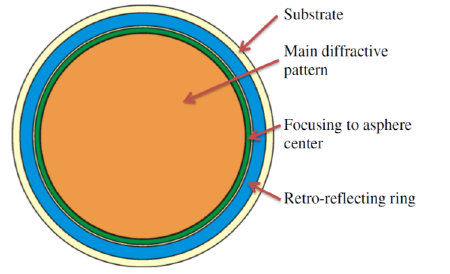
Fig. 4. Hologram layout.